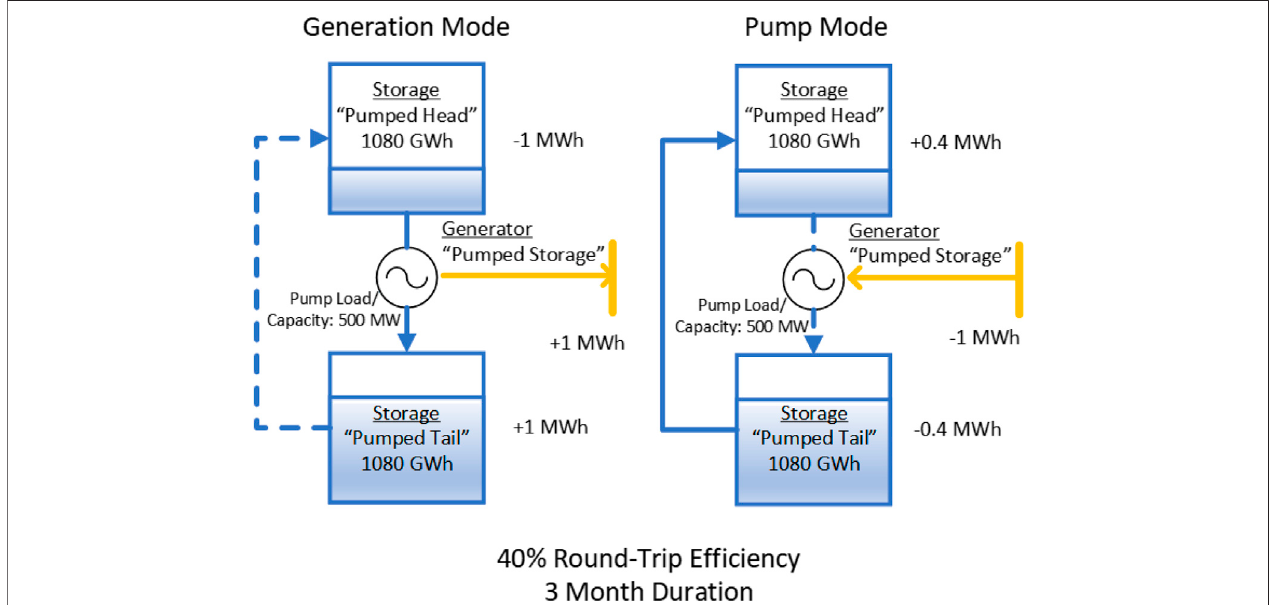
FIGURE 4 | Pumped storage object model considering a 40% round-trip storage ef fi ciency PLE (2018).